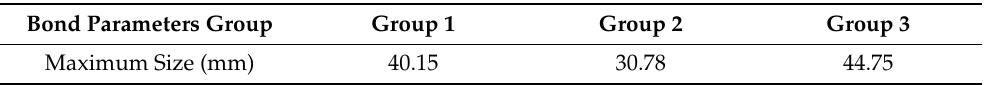
Figure 9. Maximum particle size obtained after crushing of three groups of bond parameters. ( a ) First group; ( b ) second group; ( c ) third group. Table 4. Maximum particle size after crushing.